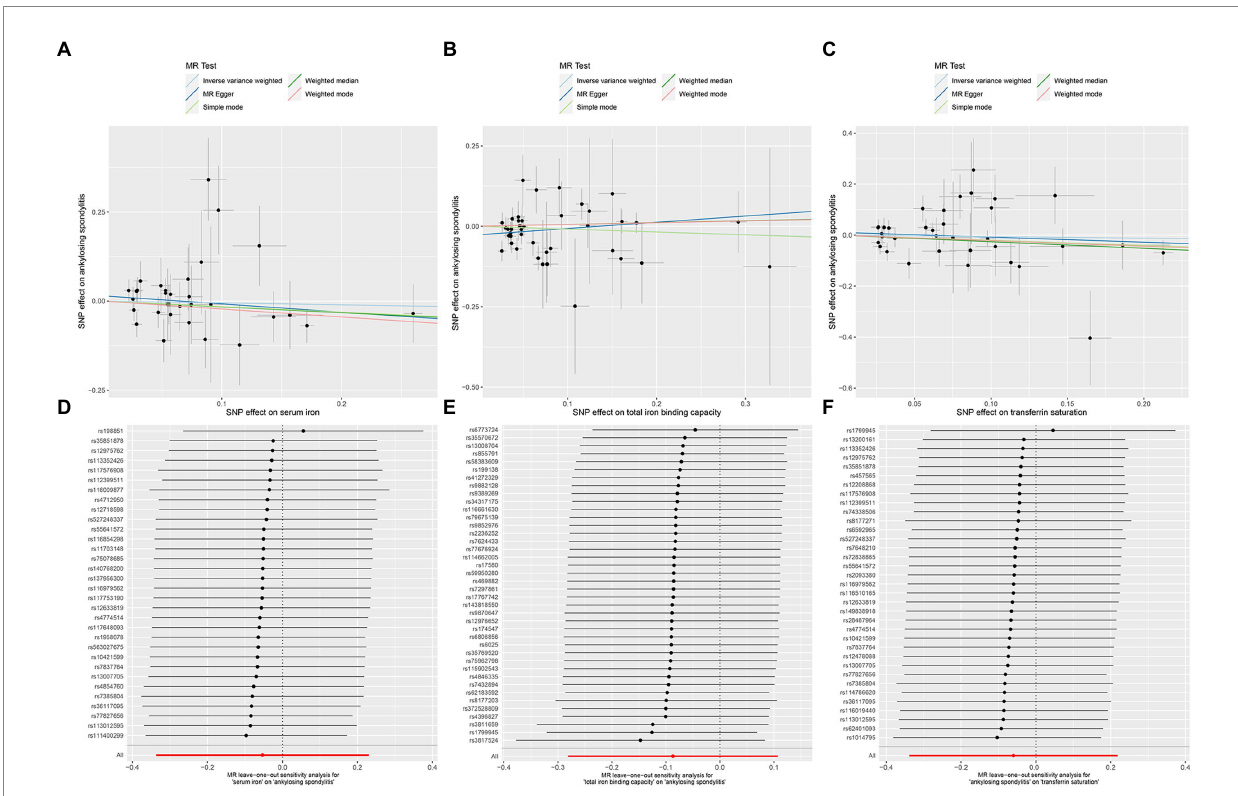
FIGURE 7 MR analysis of the three exposures (serum iron, total iron binding capacity, transferrin saturation) and outcomes (ankylosing spondylitis) after exclusion of outlier SNPs. (A) Scatter plot of serum iron and ankylosing spondylitis. (B) Scatter plot of total iron binding capacity and ankylosing spondylitis. (C) Scatter plot of transferrin saturation and ankylosing spondylitis. (D) Leave one out analysis of serum iron and ankylosing spondylitis. (E) Leave one out analysis of total iron binding capacity and ankylosing spondylitis. (F) Leave one out analysis of transferrin saturation and ankylosing spondylitis.